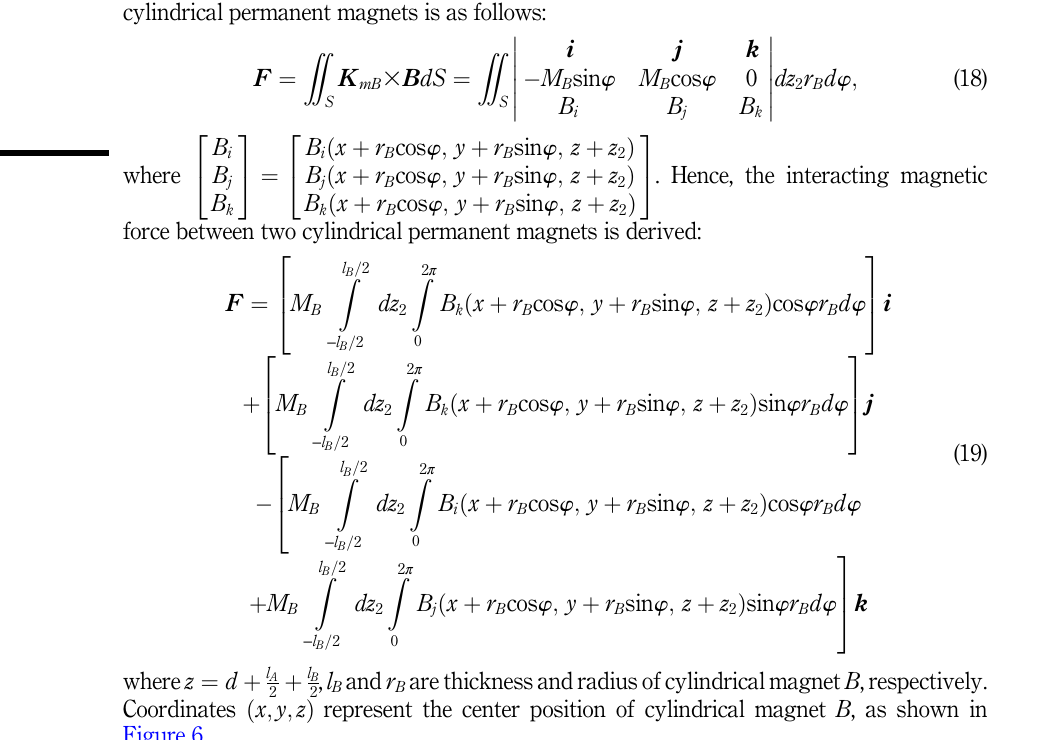
2.1.3 Spherical permanent magnet. For spherical permanent magnet magnetized along one diameter direction, the surface equivalent magnetization current is still circular. However, due to 3D curved surface of sphere in every direction, diameters of the current loops change with different positions, interaction of spherical permanent magnet is also calculated by summing interactions of the magnetizing current loops.